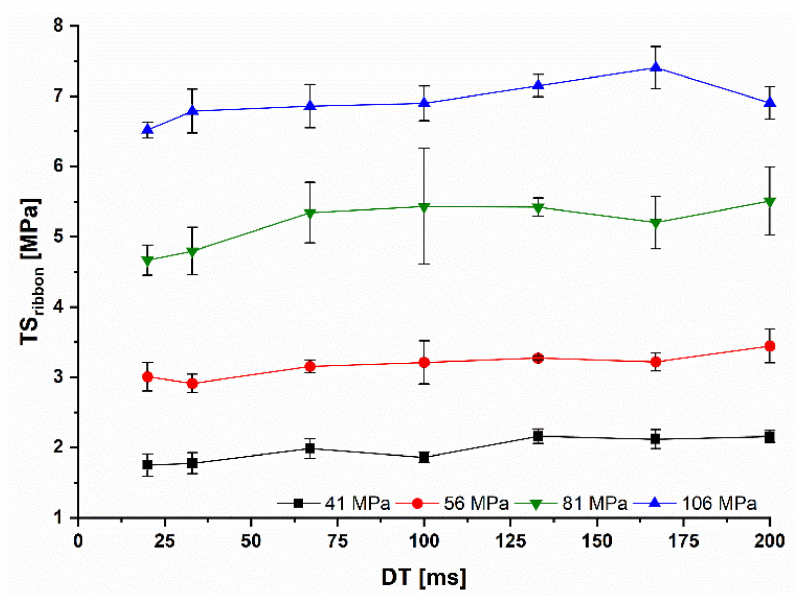
Figure 10. Ribbon tensile strength at different P max and RS of MCC ribbons; x ± s ; n = 3. The influence of the SF ribbon for lactose on the particle size could not be shown as for MCC (Figures 8 and 11). For the three highest DTs , the D50 was almost independent of the SF ribbon . Overall, the particle size was reduced in all cases with higher RS . Especially at 6 and 10 rpm, the D50 dropped for P max values of 66, 98 and 131 MPa. Above 131 MPa, the decrease in particle size was smaller.